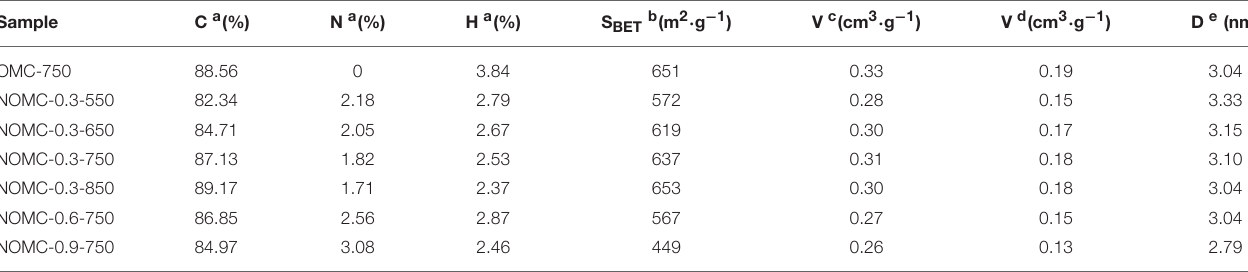
TABLE 1 | Element compositions, and textural parameters of OMC and NOMCs.